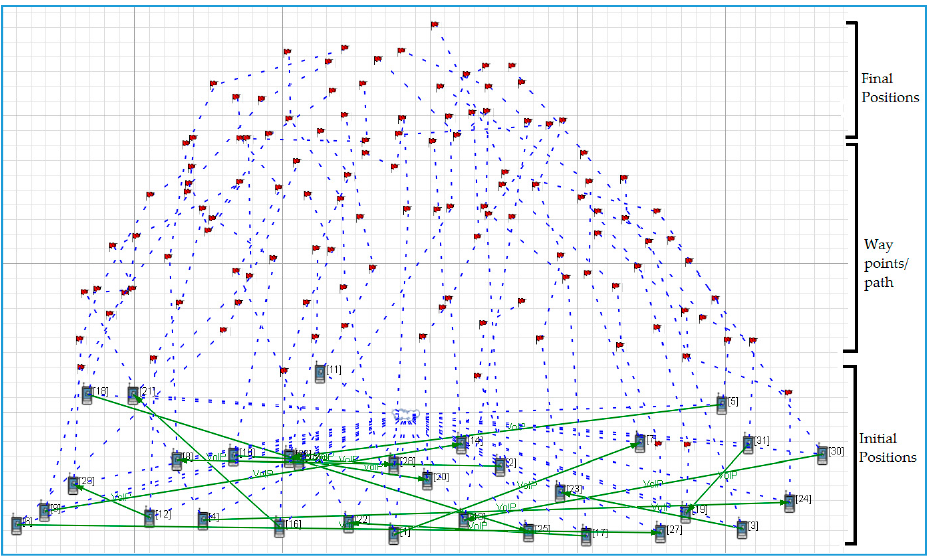
Figure 5. First responders with waypoint mobility. The flags with dotted lines show the positions to which the nodes move, the dotted lines connected to a cloud show the IPv4 subnet association. The solid lines show VoIP peers.